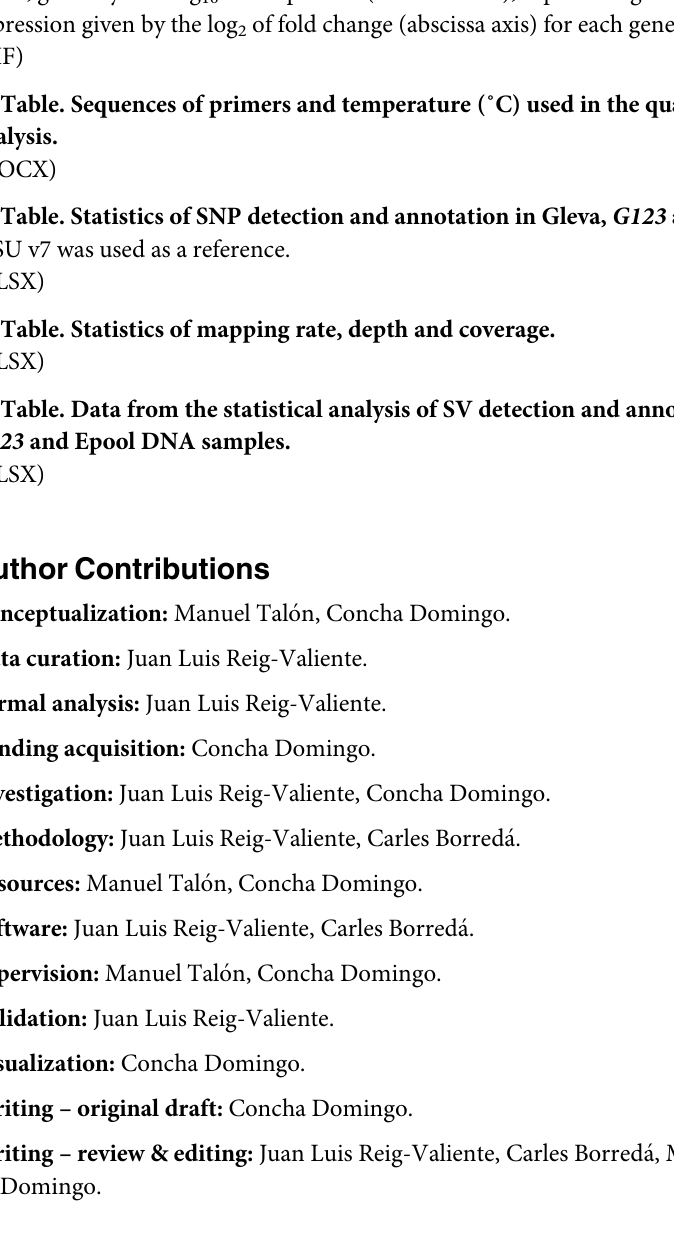
S1 Fig. Volcano plot analysis of the differential expressed genes in G123 . Statistical signifi- cance, given by the–log of the p-value (ordinate axis), is plotted against the variation of 10 expression given by the log of fold change (abscissa axis) for each gene. 2 S1 Table. Sequences of primers and temperature (˚C) used in the quantitative RT-PCR analysis. S2 Table. Statistics of SNP detection and annotation in Gleva, G123 and Epool. Nipponbare MSU v7 was used as a reference. S3 Table. Statistics of mapping rate, depth and coverage. S4 Table. Data from the statistical analysis of SV detection and annotation in the Gleva, G123 and Epool DNA